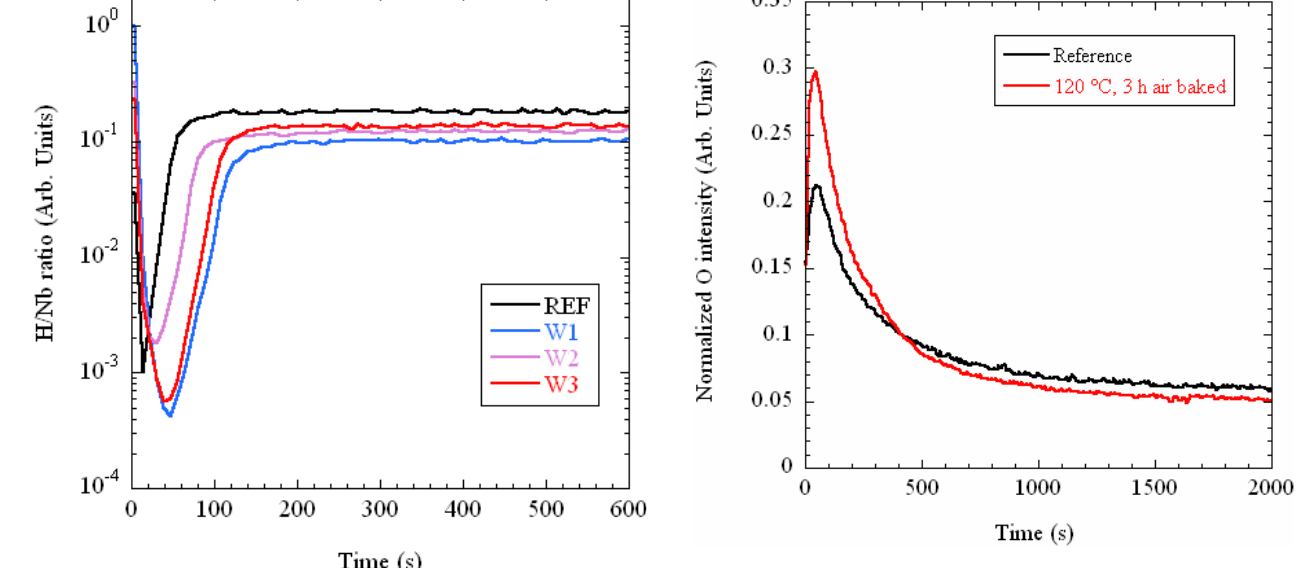
13. (Color) SIMS Hydrogen depth profiling done at NCSU ments are indicated in Table I.